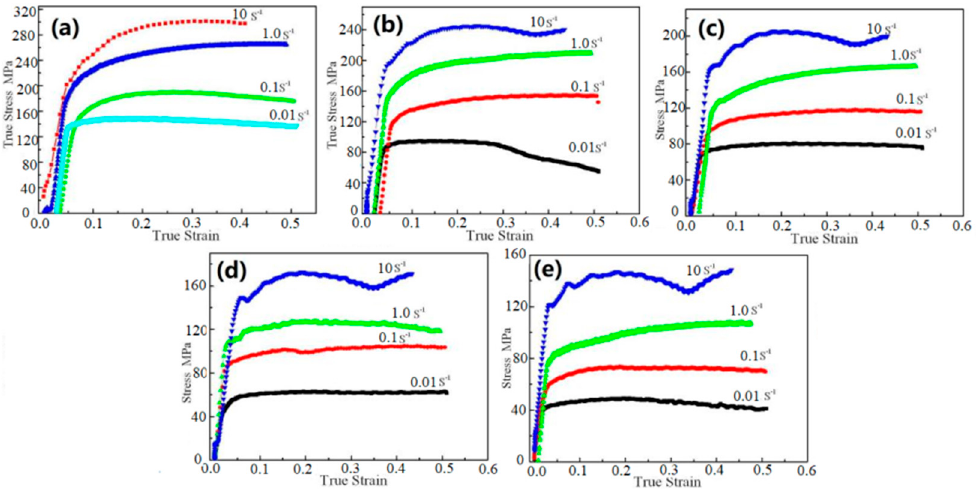
Figure 4. True stress–strain curves for the compression tested steel formed at ( a ) 1273 K, ( b ) 1323 K, ( c ) 1373 K, ( d ) 1423 K and ( e ) 1473 K.